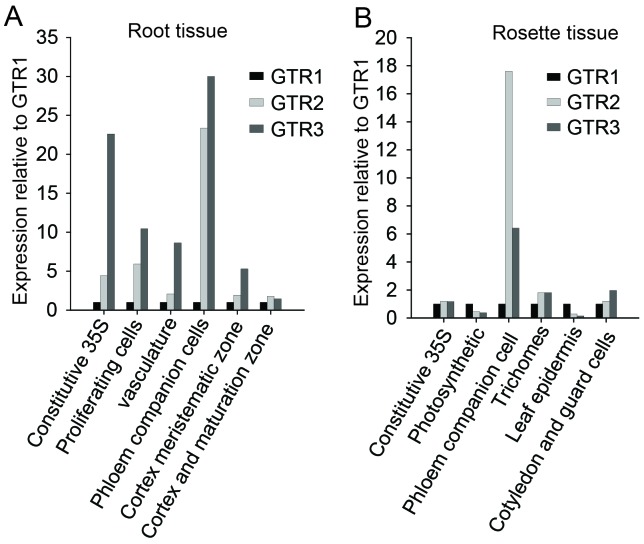
In silico expression analysis of the indole-specific glucosinolate transporter GTR3 and the broad-specificity GTR1 and GTR2 transporters.(A–B) Cell type-specific expression of GTR2 and GTR3 relative to GTR1 expression in (A) shoot and (B) root tissue of 7-day-old Arabidopsis seedlings. Data was retrieved from microarray studies of RNA bound to ribosomes that were immunoprecipitated by use of epitope-tagged ribosomal protein from seedlings (Mustroph et al., 2009). Cell type-specific expression of GTR1, GTR2 and GTR3 was inferred based on co-expression with the genes whose promoters were used for driving the ribosomal affinity tag (Mustroph et al., 2009).